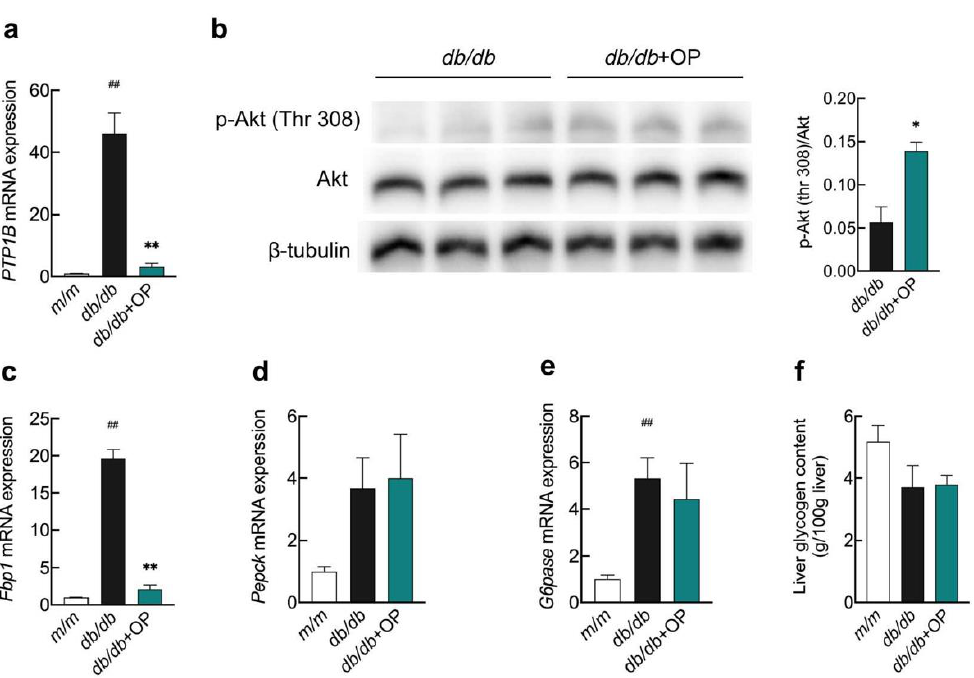
Figure 3. The effects of OP on hepatic insulin signaling pathway and key enzymes related to hepatic gluconeogenesis in db / db mice. ( a ) The mRNA expression of PTP1B ; ( b ) The protein expression of p-Akt (Thr 308); ( c – e ) The mRNA expression of Fbp1 , Pepck , and G6pase ; ( f ) The content of liver glycogen. ## p < 0.01, db / db versus m / m . * p < 0.05, db / db + OP versus db / db ; ** p < 0.01, db / db + OP versus db / db .